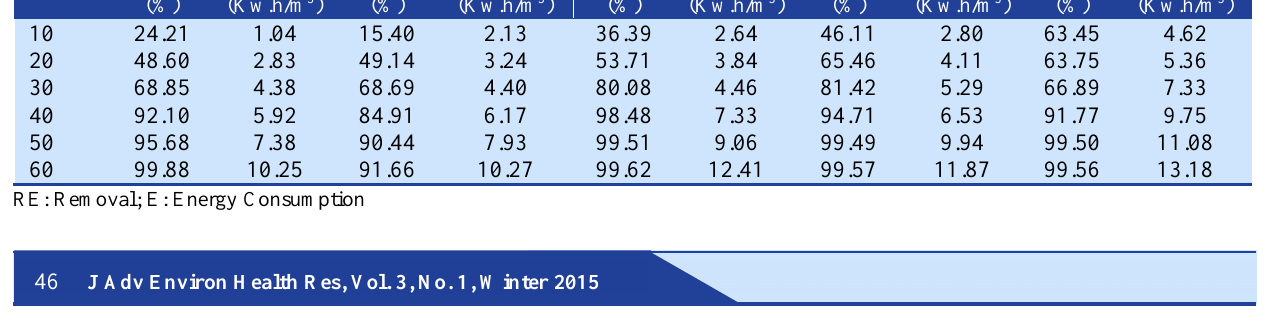
Table 2. Effect of initial dye concentration on removal efficiency and energy consumption Time